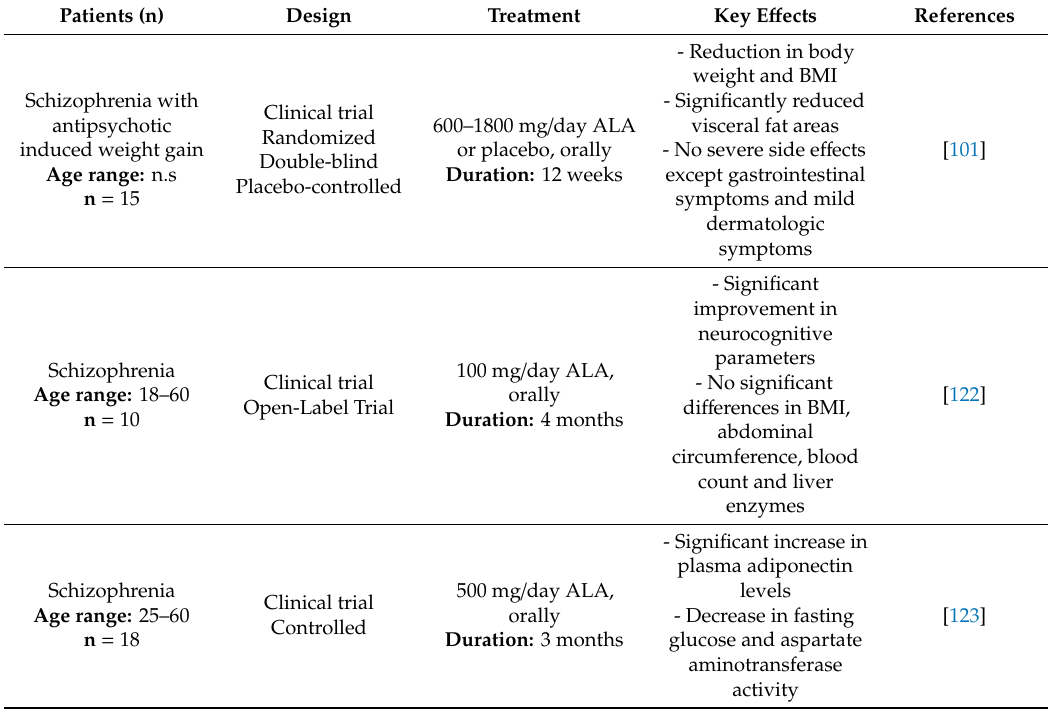
Table 3. E ff ects of ALA in schizophrenic